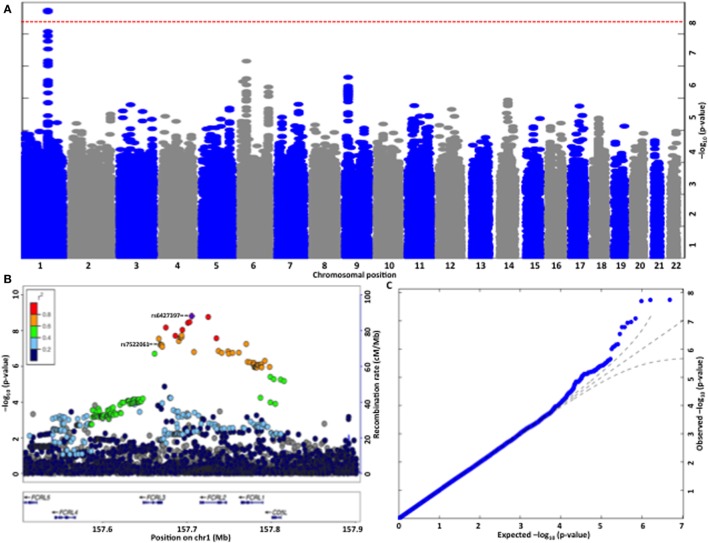
(A) Manhattan plot of the genome-wide association analysis for autoantibodies against apolipoprotein A-1 (anti-apoA-1 IgG) levels. The x-axis is chromosomal position and the y-axis is the significance (−log P; two-tailed) of association derived by the linear regression. The red line represents genome-wide significance level (p = 5 × 10−8) that was achieved by a single locus located in chromosome 1. (B) Regional plot at the Fc receptor-like (FCRL)2/3 locus on chromosome 1 showing single-nucleotide polymorphism (SNP) association strength for anti-apoA-1 IgG levels. To fine map the genome-wide significant association at the FCRL2/3 locus, we re-imputed the 400-kb window around the top HapMap-associated SNP using haplotypes from the HRC reference panel. −log10 P values (y-axis) are presented according to their chromosomal positions (x-axis). The index SNP in the analysis (i.e., SNP with the smallest P-value, rs6427397, purple diamond) and the only coding SNP identified (rs7522061) are labeled. The color intensity of each symbol reflects their linkage disequilibrium (r2) values with the index SNP, red (r2 > 0.8) through to navy blue (r2 < 0.2). Genes in each region, direction of transcription, and genomic coordinates are shown at the bottom. (C) Quantile–quantile plot of SNPs for anti-apoA-1 IgG levels. The negative logarithm of the observed (y-axis) and the expected (x-axis) P-value is plotted for each SNP (dot). The black lines indicate the null hypothesis of no true association (x = y) with 95% confidence intervals. Significant deviation from the expected (null) P-value distribution is evident only in the upper tail area (blue line), corresponding to SNPs with the strongest association.